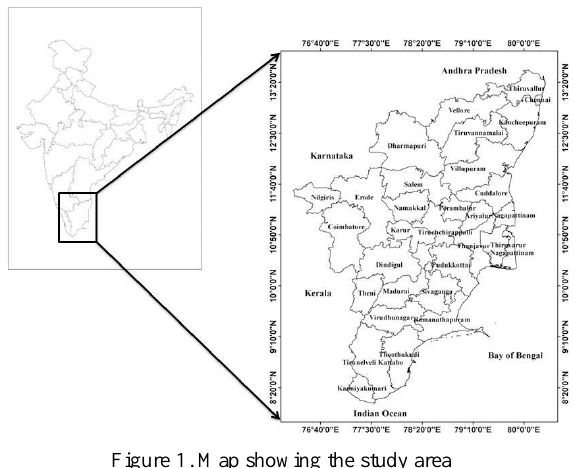
mm. But, despite being located at the foot of the Nilgiri hills, Coimbatore district on the west receives less rainfall of around 1000 mm. The interior districts also receive relatively less range of rainfall from 1000 to 2500